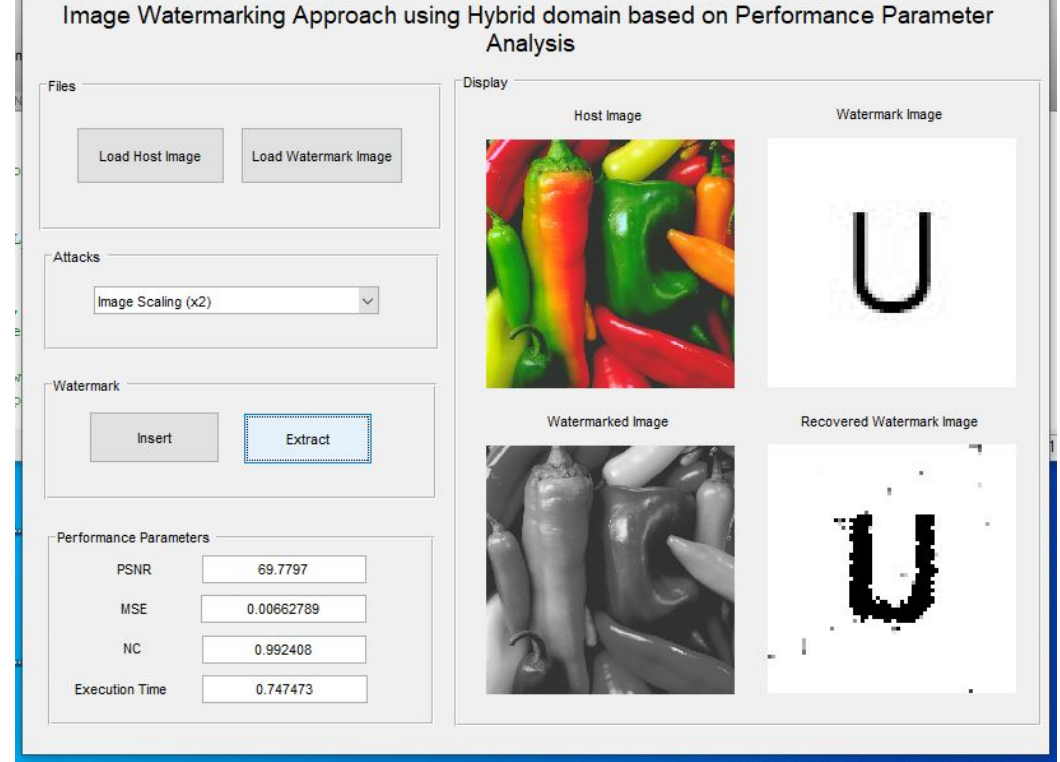
Figure 10. Image scaling attack and extraction of watermark after scaling of watermarked image.